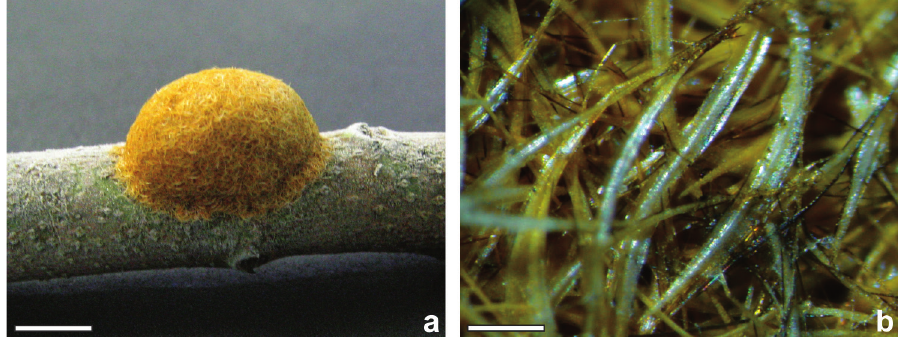
Figure 5 - Egg mass of H. oratex . (a) egg mass on a branch of the host plant; (b) detail of the layer composed of true and modifi ed setae (scales = 5 mm; 200 µm, respectively).